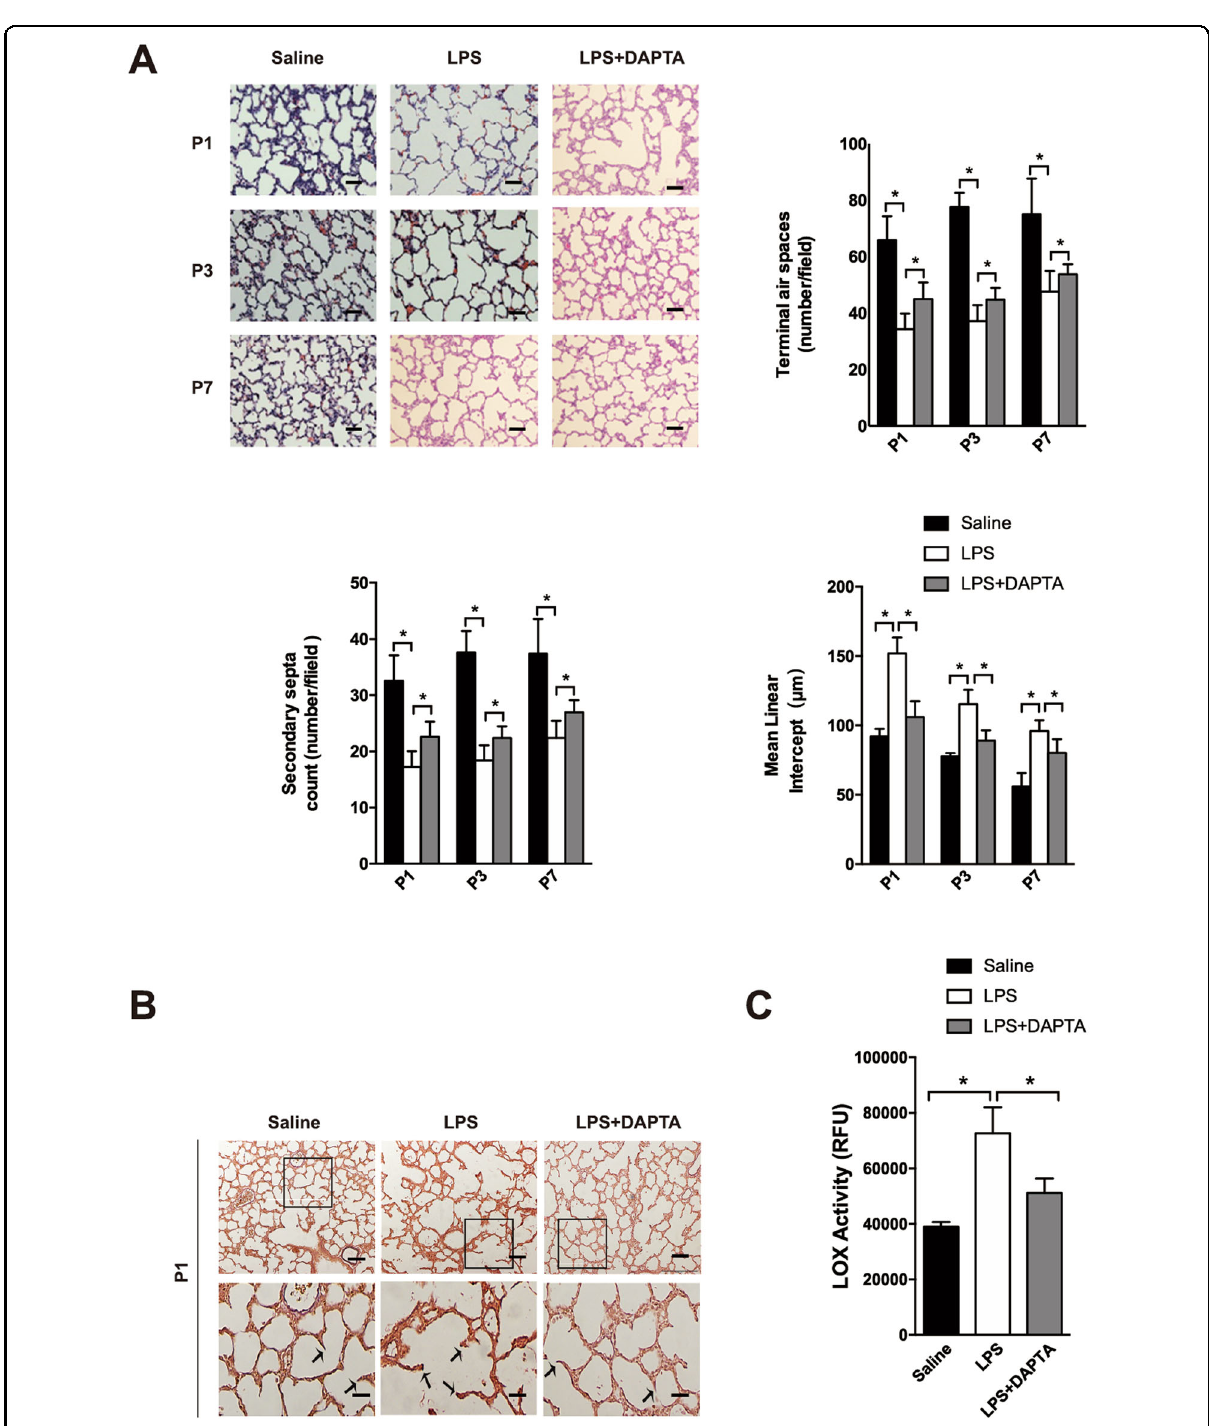
Fig. 5 CCR5 mediated arrested effects on alveolarization in antenatal LPS – treated rats. A Representative lung sections stained with H&E. Quanti fi cation of the terminal airspace, secondary septa, and MLI. Scale bar: 50 μ m. Data are expressed as mean ± SD ( n = 6), * p < 0.05. B Representative lung sections stained with gomori (Arrows). Top: Scale bar: 50 μ m. Bottom: Scale bar: 25 μ m. C Quanti fi cation of LOX enzymatic activity in whole lung lysate of P1 rats. Data are expressed as mean ± SD ( n = 7), * p < 0.05.